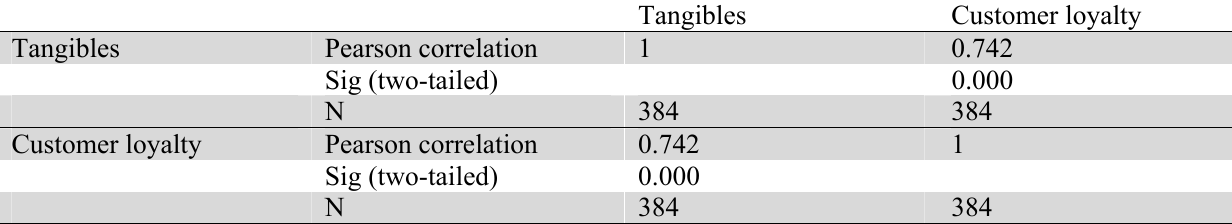
Tangibles Customer loyalty